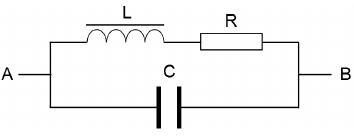
Figure 8 Sketch map of RLC parallel